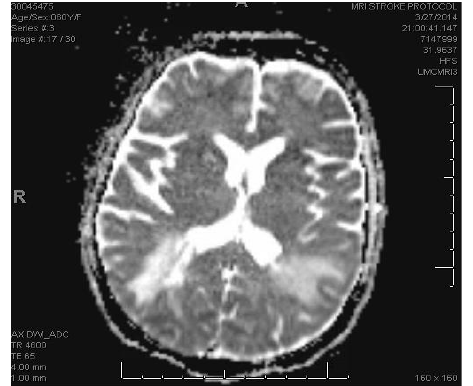
Figure 1 : There are foci of restricted diffusion with surrounding vasogenic edema and hemorrhagic products involving bilateral parietal lobes (as shown) in addition to small foci involving bilateral occipital lobes (not